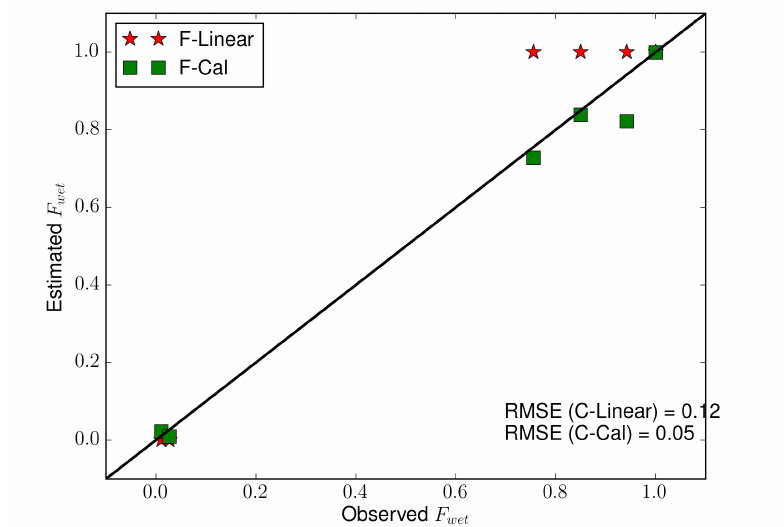
Figure 19. Comparison of the observed and estimated F wet for the C-Linear and C-Cal